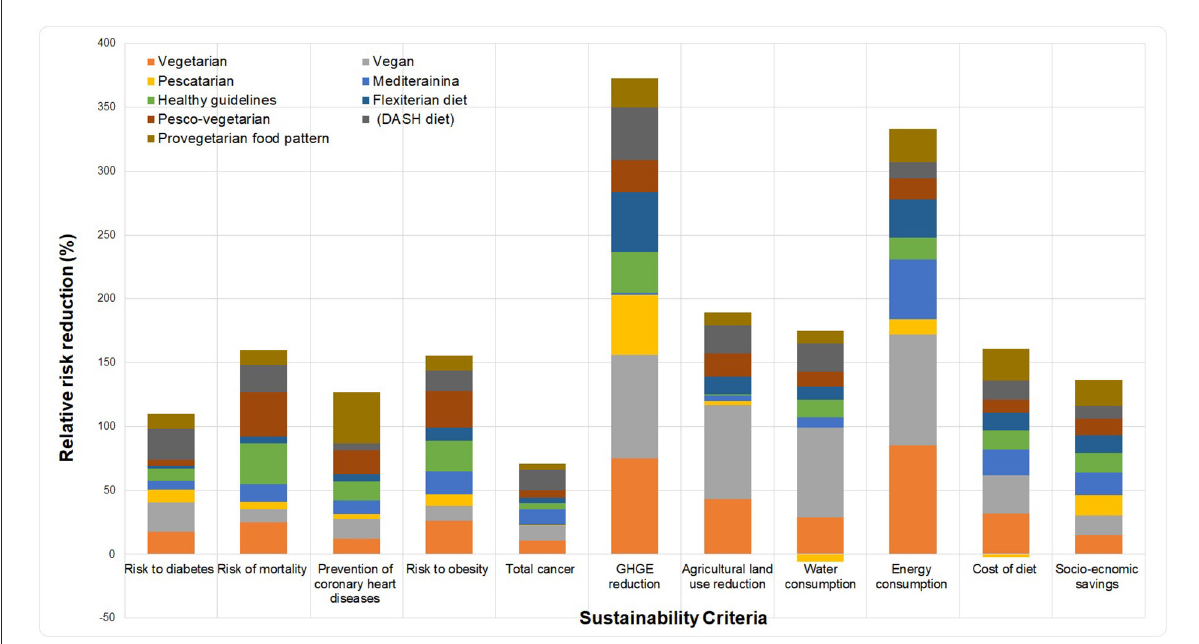
FIGURE9 Relative reduction/increase in health and environmental impact of different dietary concepts.